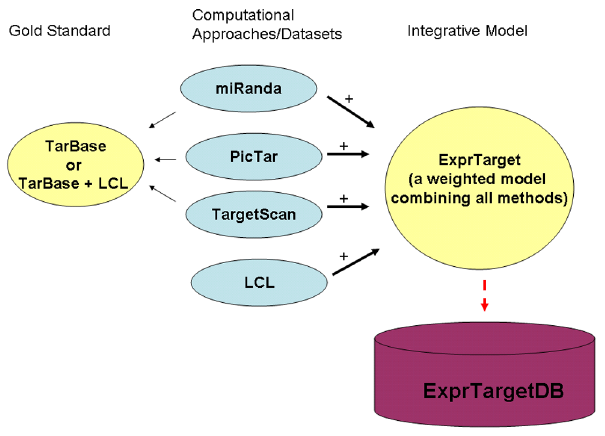
Figure 1. ExprTarget integrates various methods and datasets. Individual computational methods (miRanda, PicTar, TargetScan) were evaluated using both TarBase and (TarBase + LCL) as gold standards. ExprTarget integrates individual computational methods (miRanda, PicTar, TargetScan) and the LCL expression data. ExprTarget was evaluated using TarBase as gold standard. ExprTargetDB was developed to house the predictions by ExprTarget. LCL refers to the miRNA and mRNA expression data generated on a panel of lymphoblastoid cell lines from the HapMap.